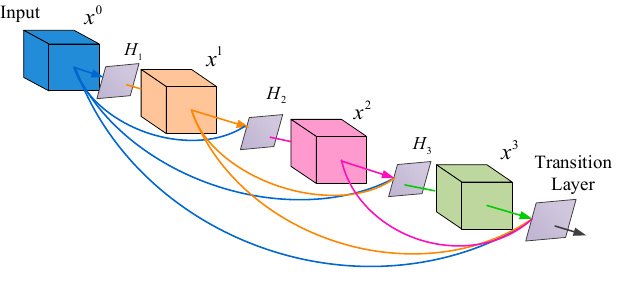
Figure 2. A four-layer dense block.